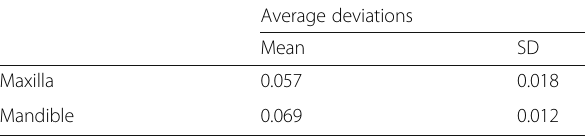
Table 2 Average deviations (mm) between the iTero and TRIOS scanners obtained from a three-dimensional superimposition